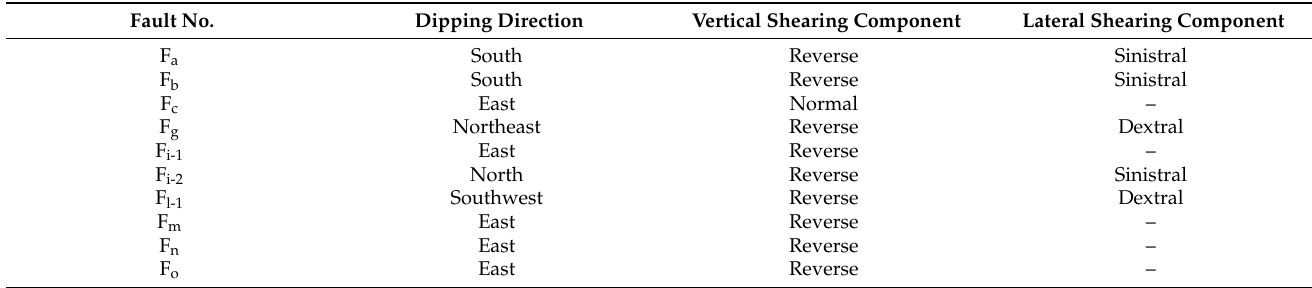
Table 2. The characteristics of newly identified active faults in Jiujing region. Fault